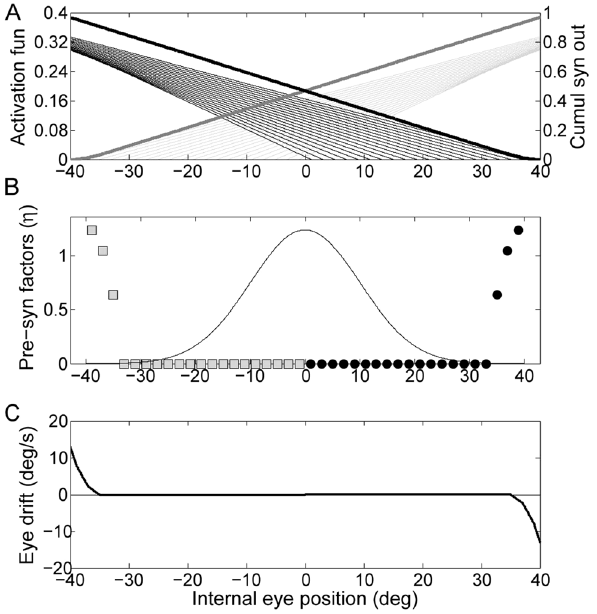
Figure 5. Simulation of the network without tuning. Panel A shows the output of the synaptic activation function of each neuron (thin lines) as a function of the internal representation of eye eccentricity ( D ), the zero of each line indicates the neuron threshold, i.e. the eccentricity at which the inhibitory cutoff takes place. The thick lines are the cumulative output of both sides of the network, obtained by combining all the synaptic activation functions with their factor g . Panel B shows the presynaptic factor g of each neuron, indexed according to the threshold shown in the upper panel, here set to the same value for all neurons to illustrate the general features of a non- tuned network. Panel C shows the PV plot for the internal representation of eye position.